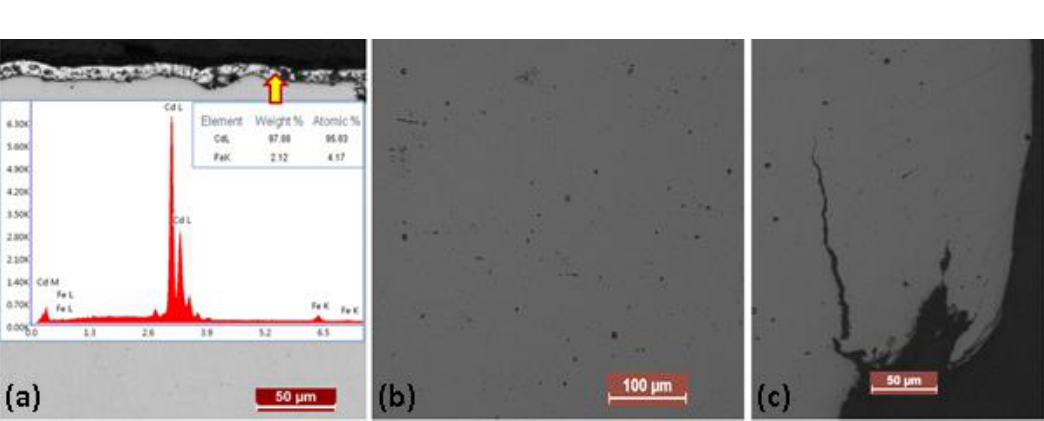
Fig. 9: Optical micrographs of the failed sample in un-etched condition: (a) presence of cadmium coating at the surface as supported by SEM EDS pattern, (b) oxides and sulphide stringers in microstructure and (c) cracks starting from the fracture surface.